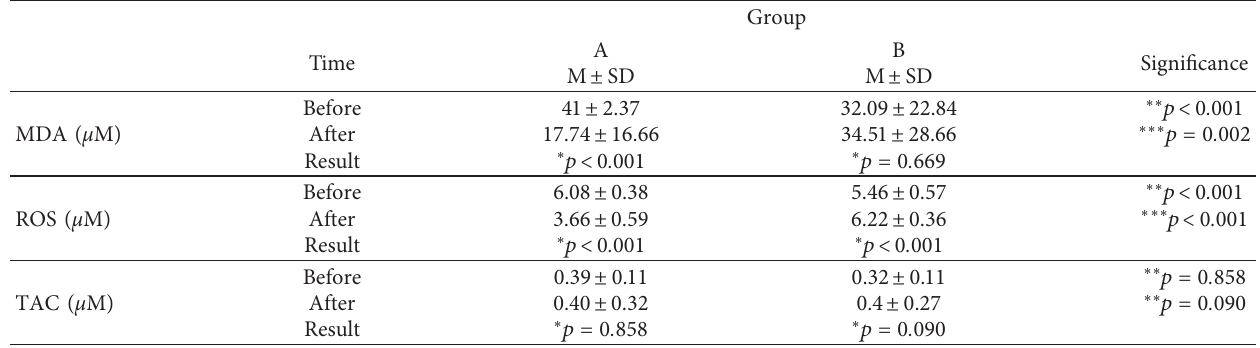
Table 2: OS markers before and after intervention in treatment and placebo groups.